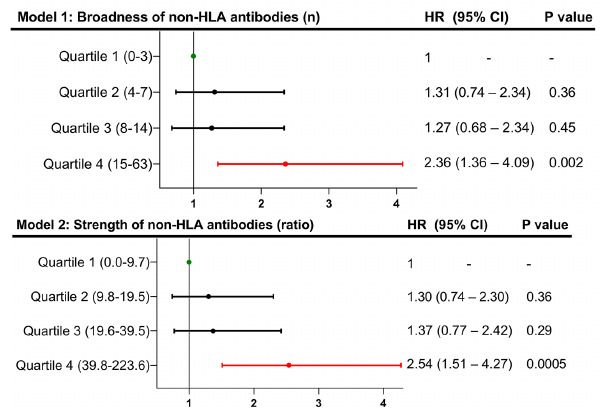
FIGURE 3 | Multivariable Cox regression analysis of the occurrence of ABMR h in the absence of HLA-DSA, according to different quartiles of the broadness and strength of pretransplant non-HLA antibodies (N=774). Each multivariable Cox model was adjusted for the presence of anti-HLA antibodies, HLA-A, -B, -DR, -DQ antigen mismatches, repeated transplantation, deceased donation, recipient sex, recipient and donor age, and induction